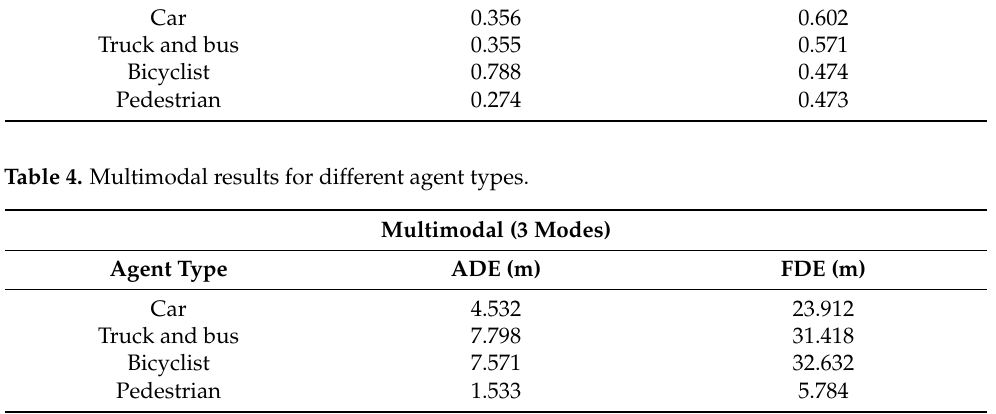
Figure 13. Tra ffi c scene prediction with the unimodal approach. In this scenario, the bus is stopping at the bus station.